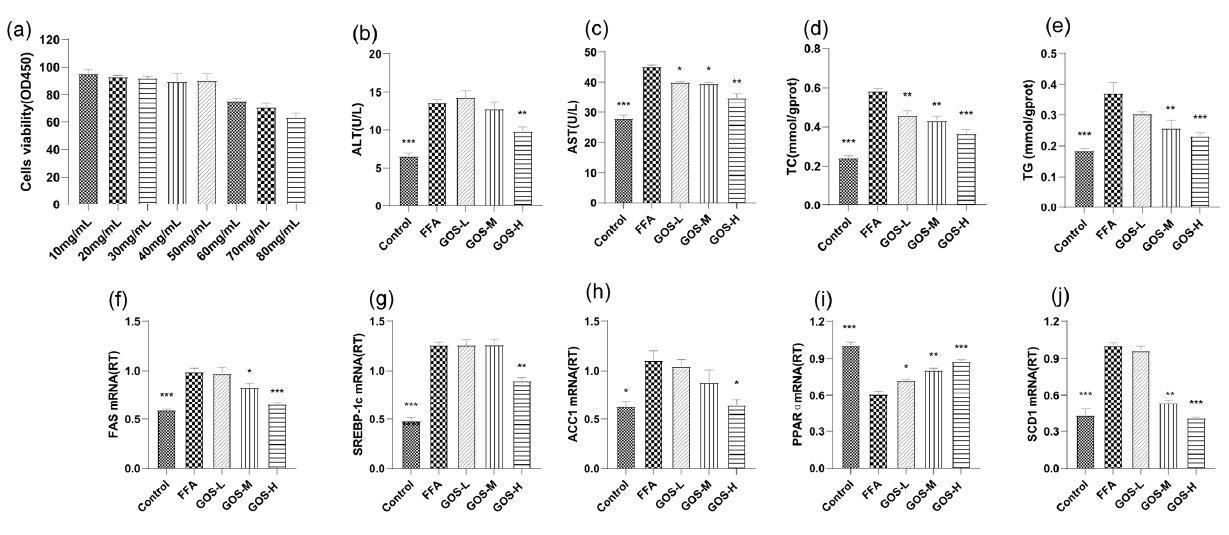
Figure 12. ( A ) ( a ) Cell survival rates under different GOS concentrations ( n = 6, mean ± SEM). ALT ( b ) and AST ( c ) contents in cell culture medium, intracellular TC ( d ) and TG ( e ) contents in each group after administration ( n = 6, mean ± SEM). Effects of GOS on the expression of FAS ( f ), SREBP- 1c ( g ), ACC1 ( h ), PPAR α ( i ), SCD1 ( j ) PPAR γ 1 ( k ), PPAR γ 2, ( l ) IL-1 β ( m ), TNF- α ( n ), and IL-6 ( o ) genes in each group ( n = 6, mean ± SEM). Note: * p < 0.05, ** p < 0.01, *** p < 0.001 vs. the FFA group. ( B ) Oil red O staining of cells in each group (400×). 3.2.3. The Effect of GOS on the Lipid Metabolism Indexes of HepG2 Cells Figure 12(Af–h) shows that after GOS intervention, GOS reduced the high expression of FAS, SREBP-1c, and ACC1 and inhibited the de novo synthesis of lipids. Figure 12(Ai,j) shows that, compared with the control condition, FFA stimulation reduced the expression of PPAR α in the cells and increased the expression of SCD1. GOS intervention signifi- cantly increased the expression of PPAR α and SCD1. Figure 12(Ak,l) shows that GOS in- tervention reduced the increased expression of PPAR γ and accelerated lipid export. As shown in Figure 12(Am–o), after GOS intervention, the expression of inflammatory factors was reduced, protecting cells from damage.